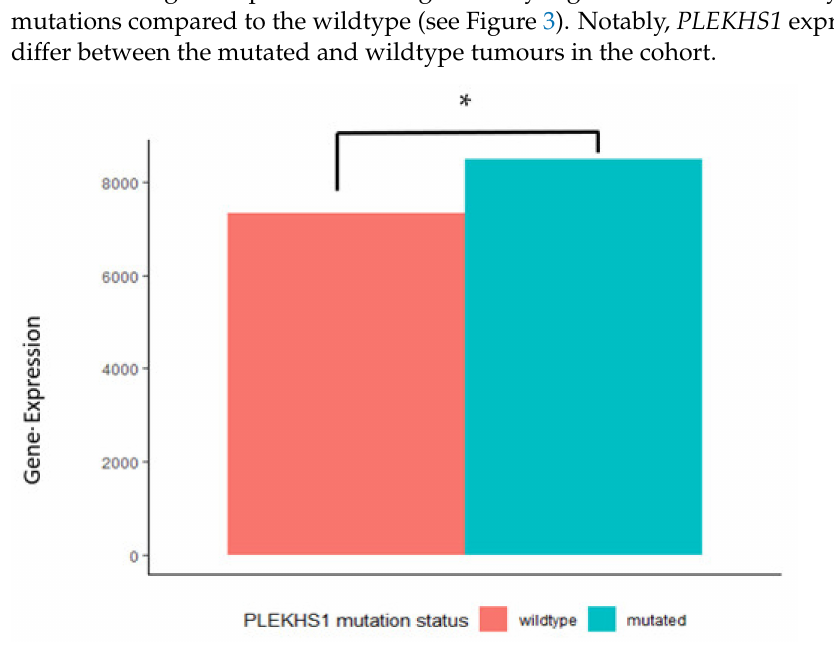
Figure 3. The median mRNA levels of PLEKHS1 and the IGF axis were plotted for those with and without the PLEKHS1 mutation. IGFBP3 mRNA levels were significantly increased in those carrying the PLEKHS1 mutation compared to those with the wildtype (* p = 0.05). Wilcoxon sum of ranks test was